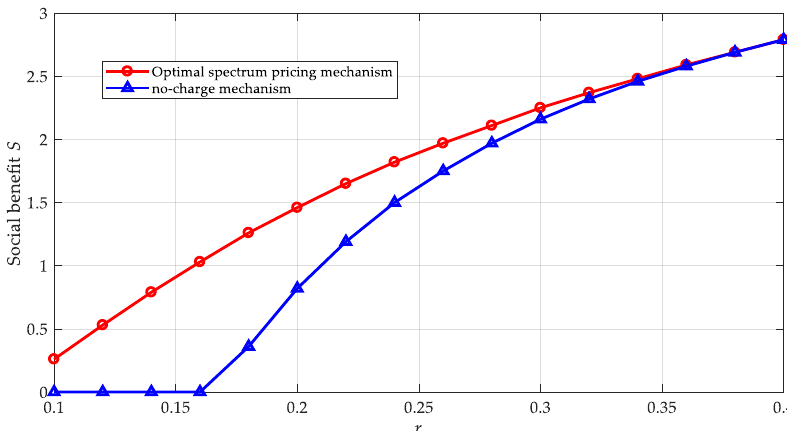
Figure 3. The impact of r on the social benefit S under different spectrum pricing mechanisms in Exp model.